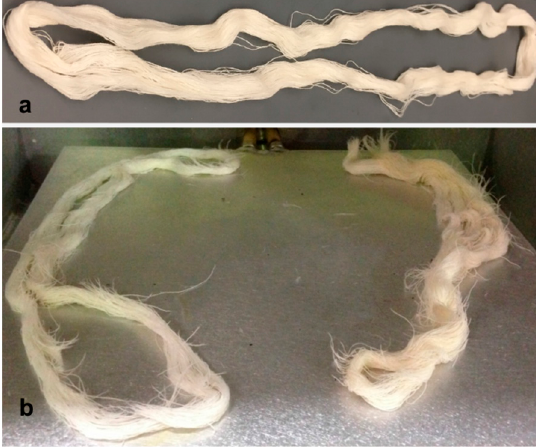
Figure 1. ( a ) Control cotton yarn with no plasma exposure and no visual yarn breakages and ( b ) the visual breakages observed after plasma degradation of yarns exposed to 90 min plasma exposure at 0.46 W/cm 2 .